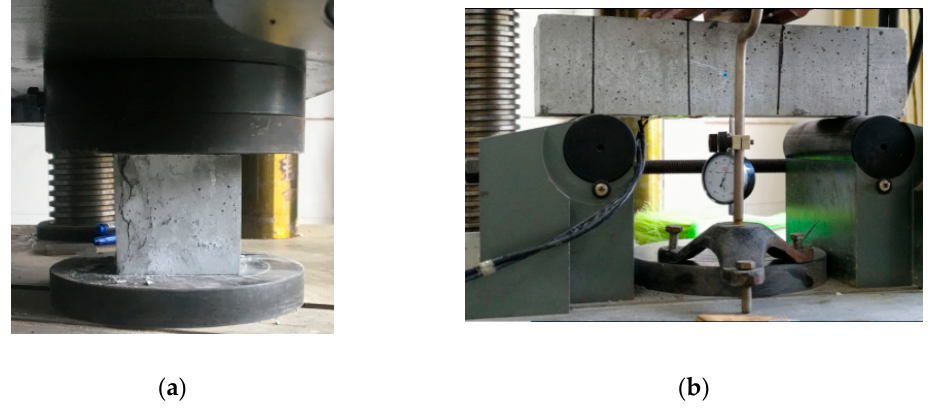
Figure 6. Performance test of UHPC material: ( a ) cubic compression test and ( b ) four-point bending test.